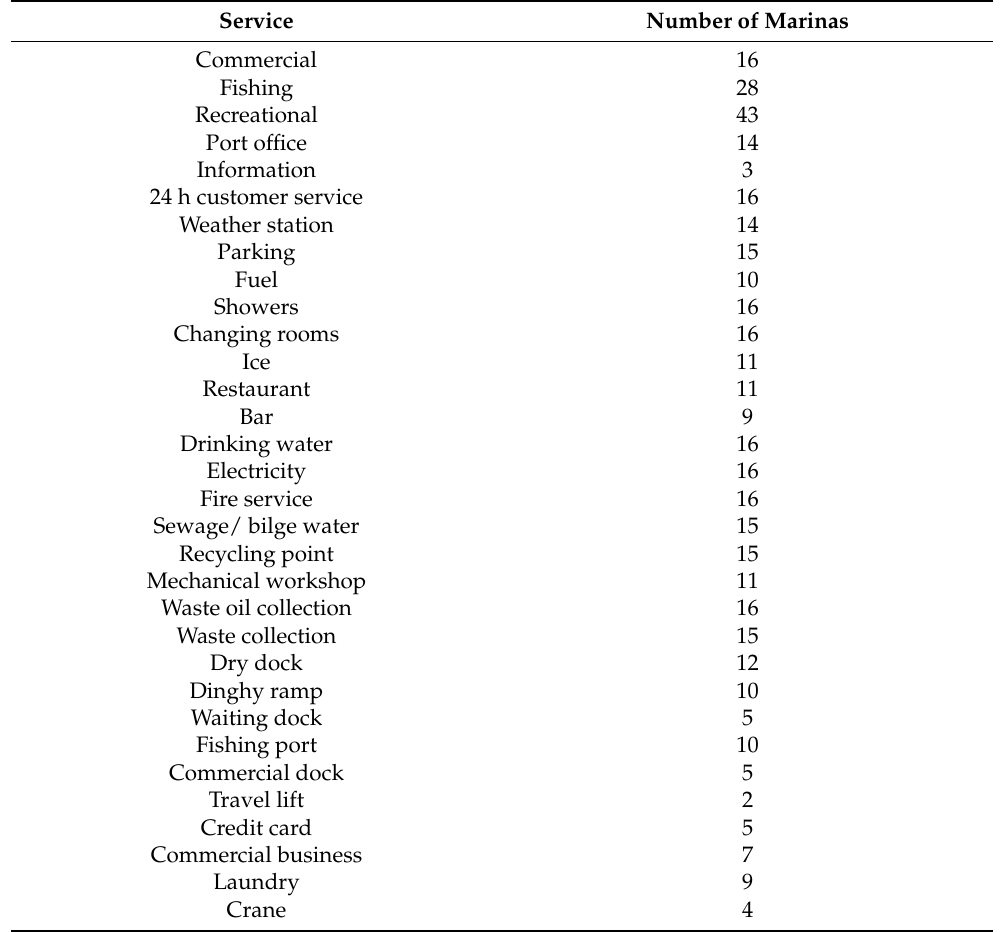
Table 2. Services of the Andalusian ports APPA